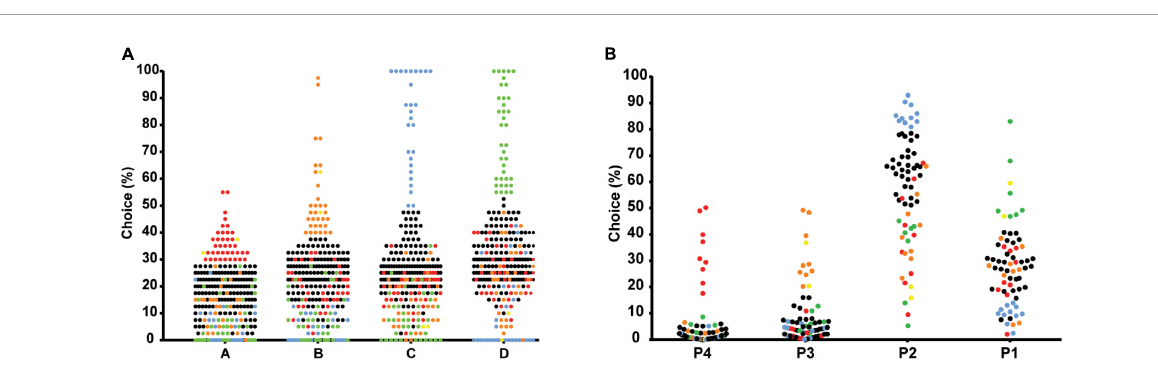
( Figure 5A ). The mean percentages of individual deck choices for each subgroup of extreme individuals are displayed in Table 5 .